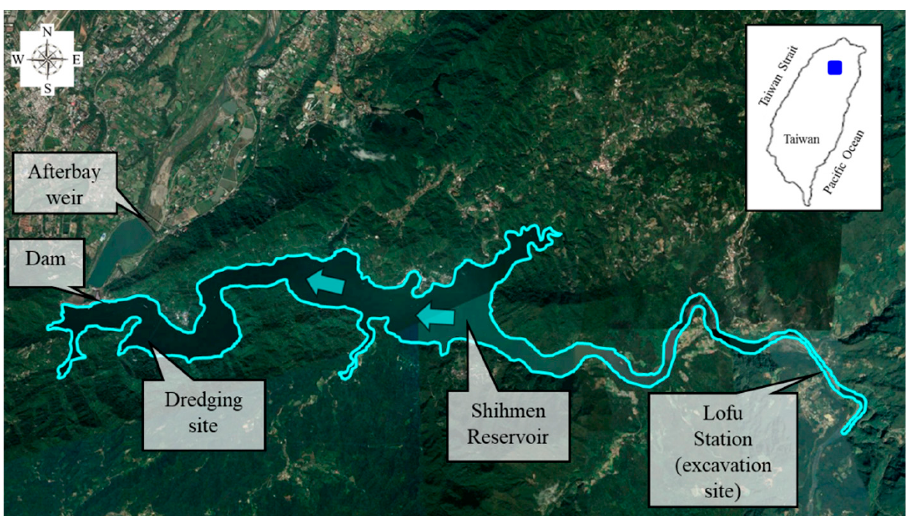
Figure 1. Location map and geometry of Shihmen Reservoir.